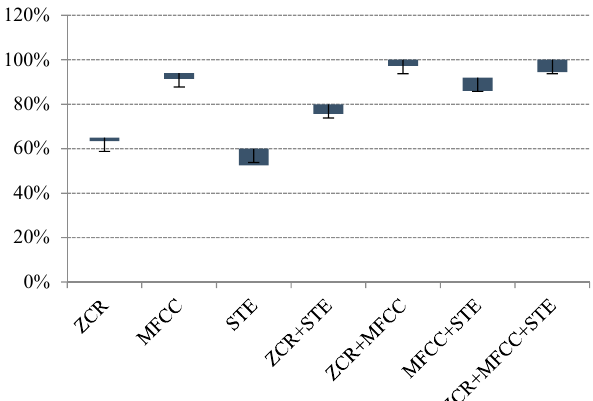
Figure 8. Classification performances of multi-class MSVM of various sets of features and length of event signal.